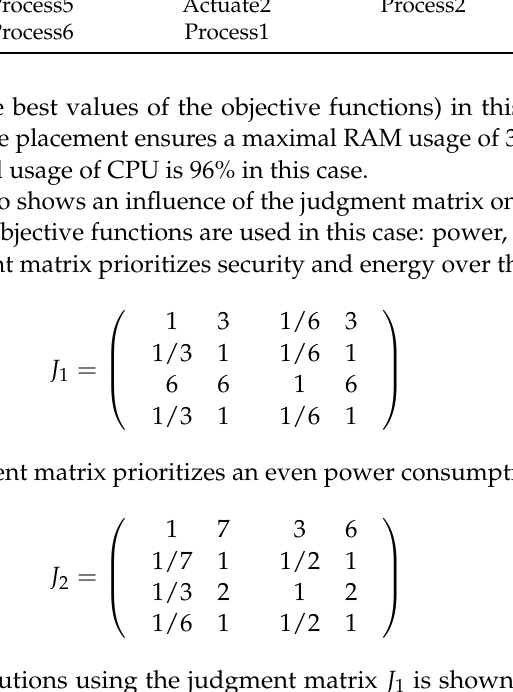
Sense3 Process2